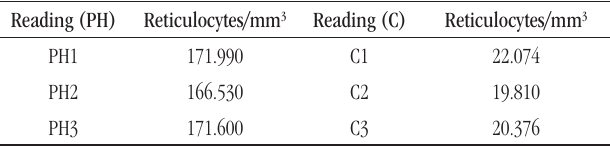
tABLE 4 – Carry-over determination of the FC reticulocyte count (BD FACSCaliburTM) using AO (new